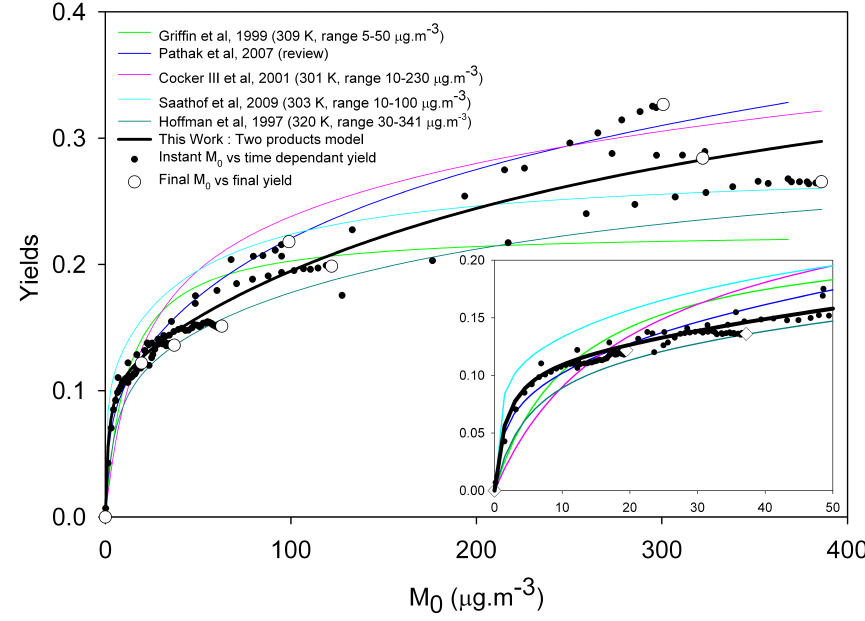
Fig. 12. Comparison of yield obtained in this work (Table 7) with the two-product models obtained from other studies for the dry and dark ozonolysis of α -pinene. Note: the relation proposed by Pathak et al. (2007) is based on the VBS